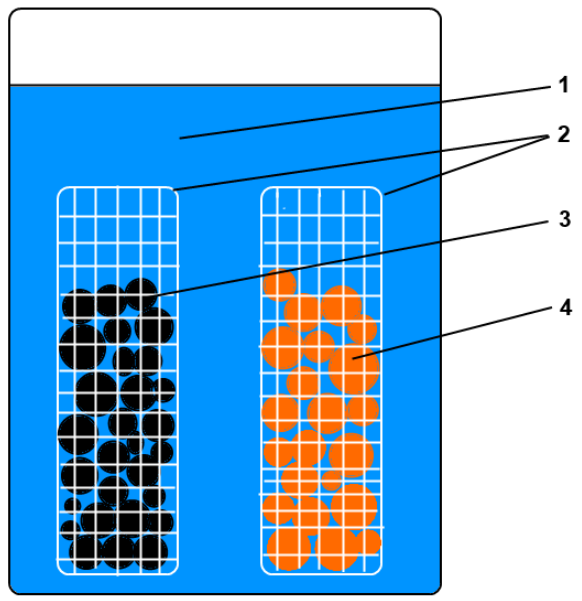
Figure 1. Interpolymer system based on Amberlite IR120 and AB-17-8 ion exchangers. 1 —salt solution; 2 —polypropylene cell; 3 —Amberlite IR120; 4 —AB-17-8.